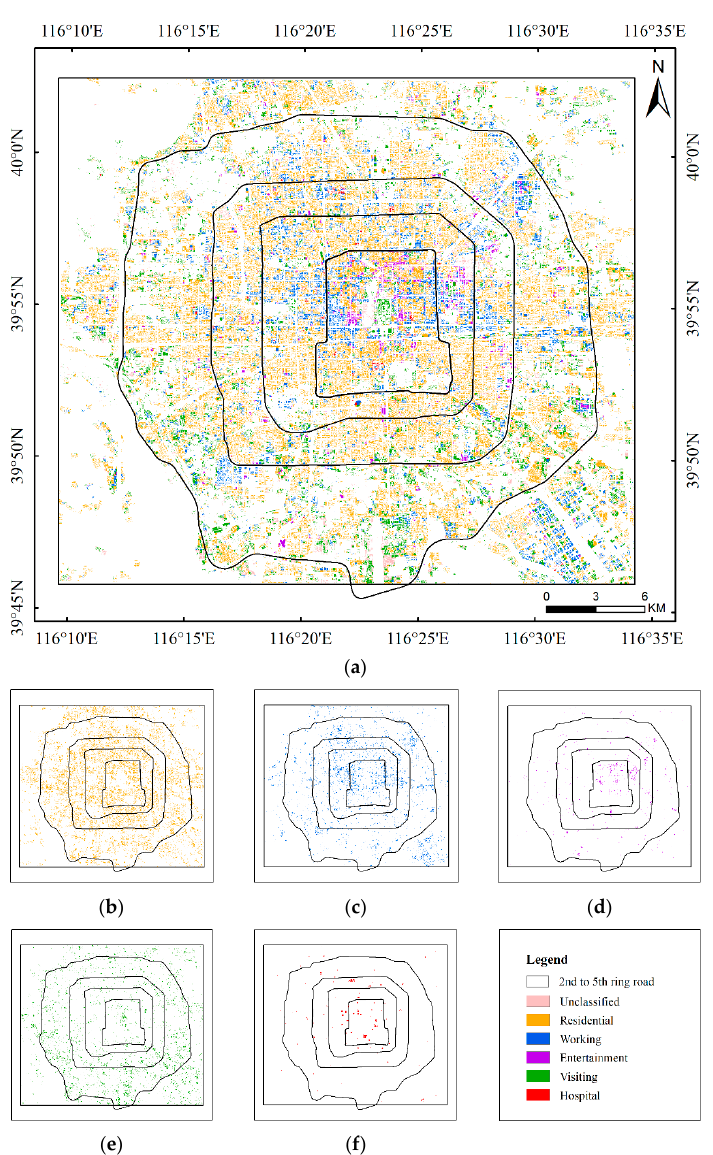
Figure 19. RF model-predicted BFT map for the main urban center of Beijing: ( a ) All five BFTs; ( b ) R ; ( c ) W ; ( d ) E ; ( e ) V ; ( f ) H .